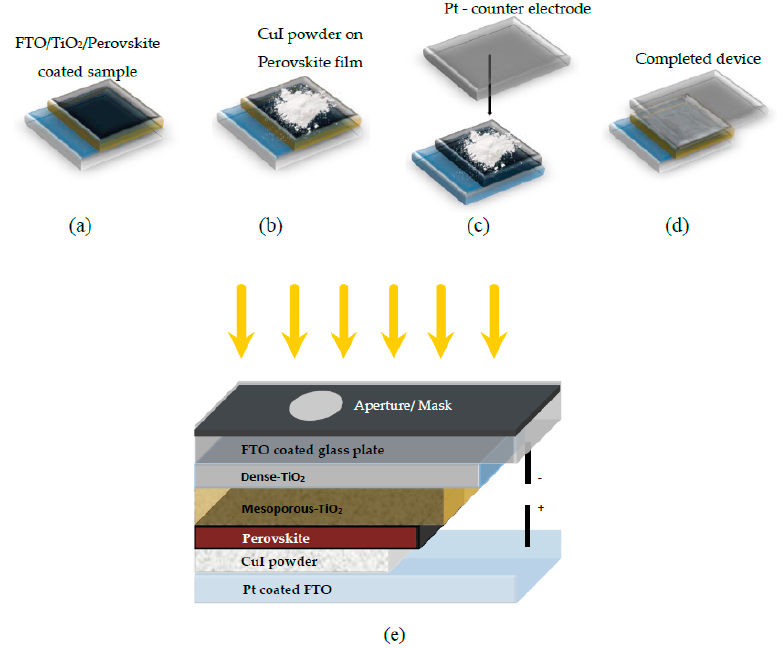
Figure 1. ( a − d ) step by step schematic of powder pressing method for incorporating cuprous iodide (CuI) powder as HTM in perovskite solar cells (PSCs) and ( e ) schematic representation of CuI device architecture.